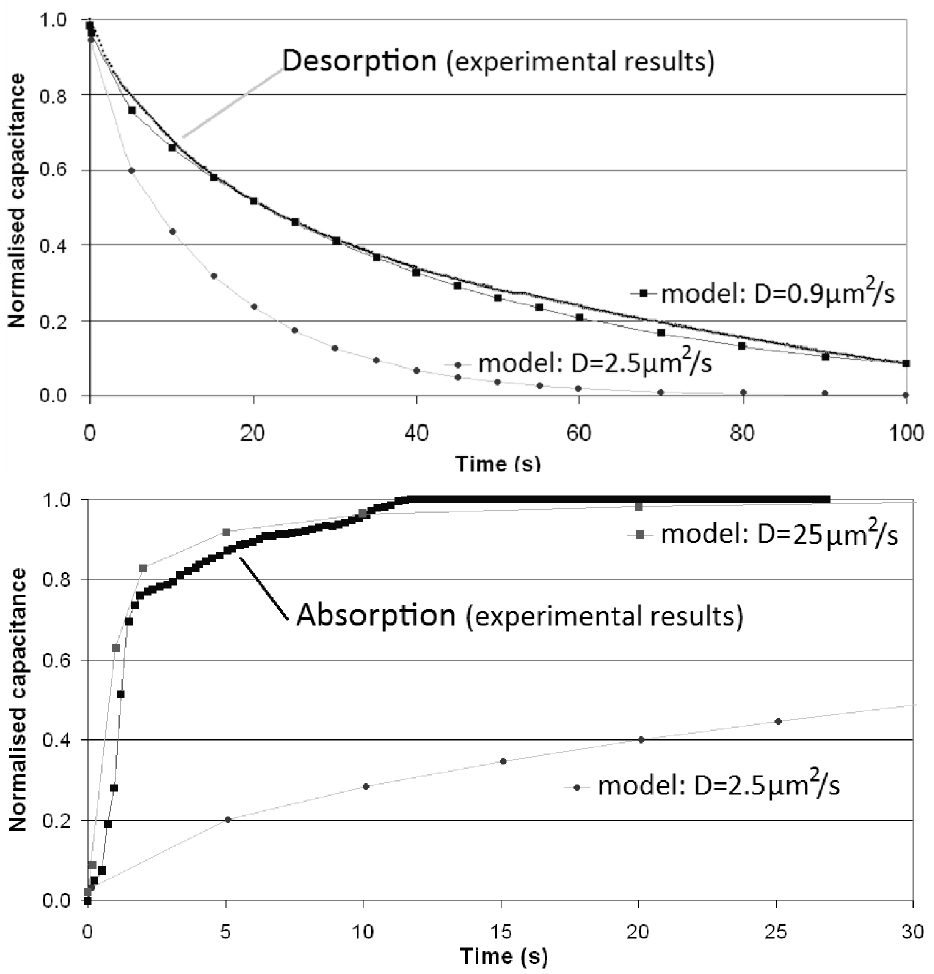
Figure 7. Dynamic behaviour of the humidity sensor: desorption and absorption